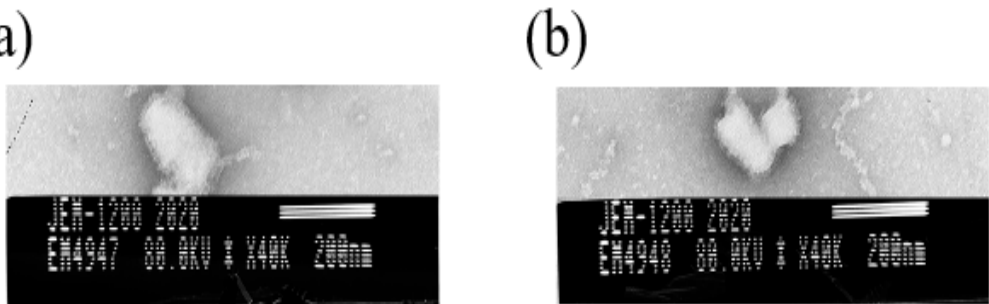
Figure 5. Observation of the recombinant viruses rSRV9-H and rSRV9-F via transmission electron microscopy. The supernatant of recombinant viruses ( a ) rSRV9-H and ( b ) rSRV9-F were inactivated with glutaraldehyde and dropped onto a special copper mesh for TEM. After incubation at room temperature for 5 min, the cells were stained with 1% phosphotungstic acid for 3 min. The excess liquid on the edge of the copper mesh was removed using filter paper. After the copper mesh was dry, it was observed under a transmission electron microscope.